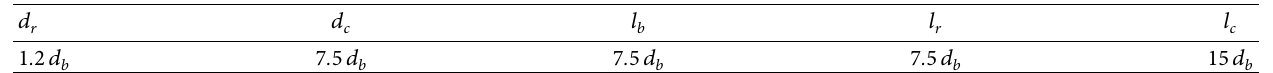
Figure 8: Dimension of the bond-slip specimen. Table 3: Dimension of the bond-slip specimen ( d